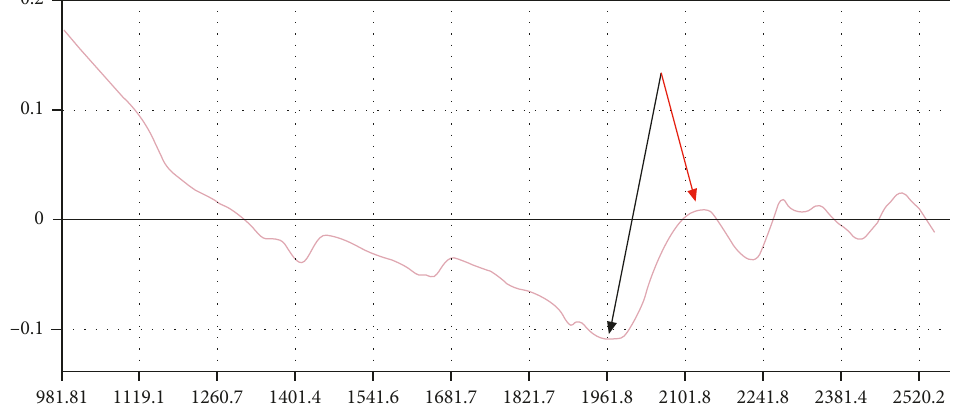
Figure 6: The loading plot for